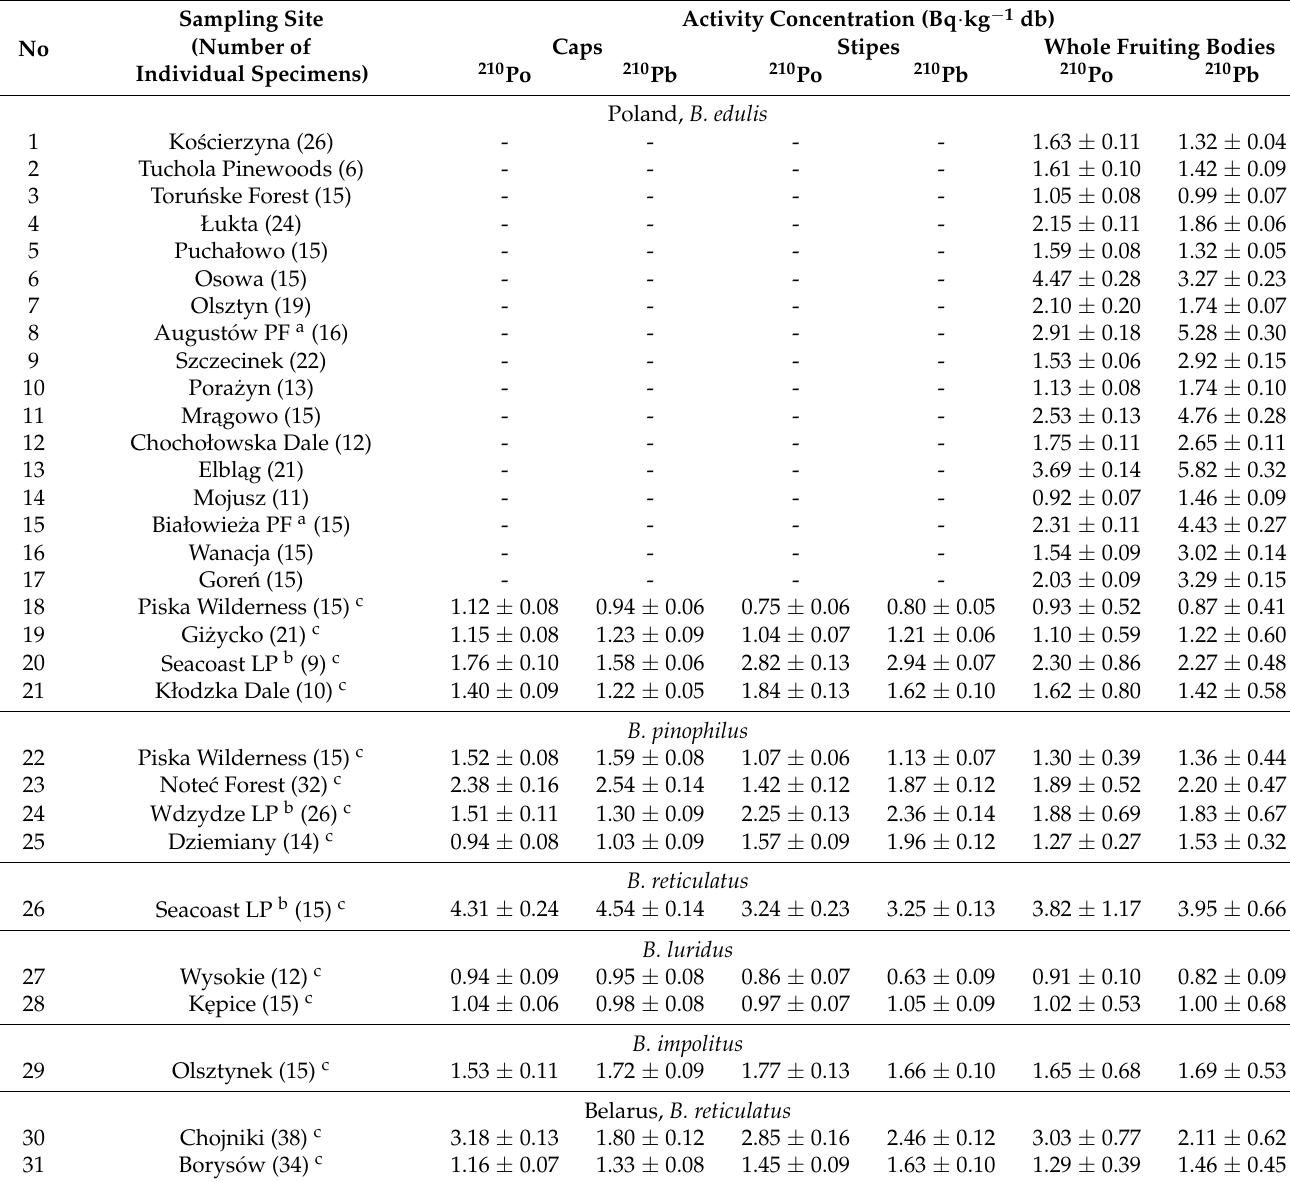
Table 1. 210 Po and 210 Pb activity concentrations in boletes; a PM—Primeval Forest, b LP—Landscape Park; c — 210 Po